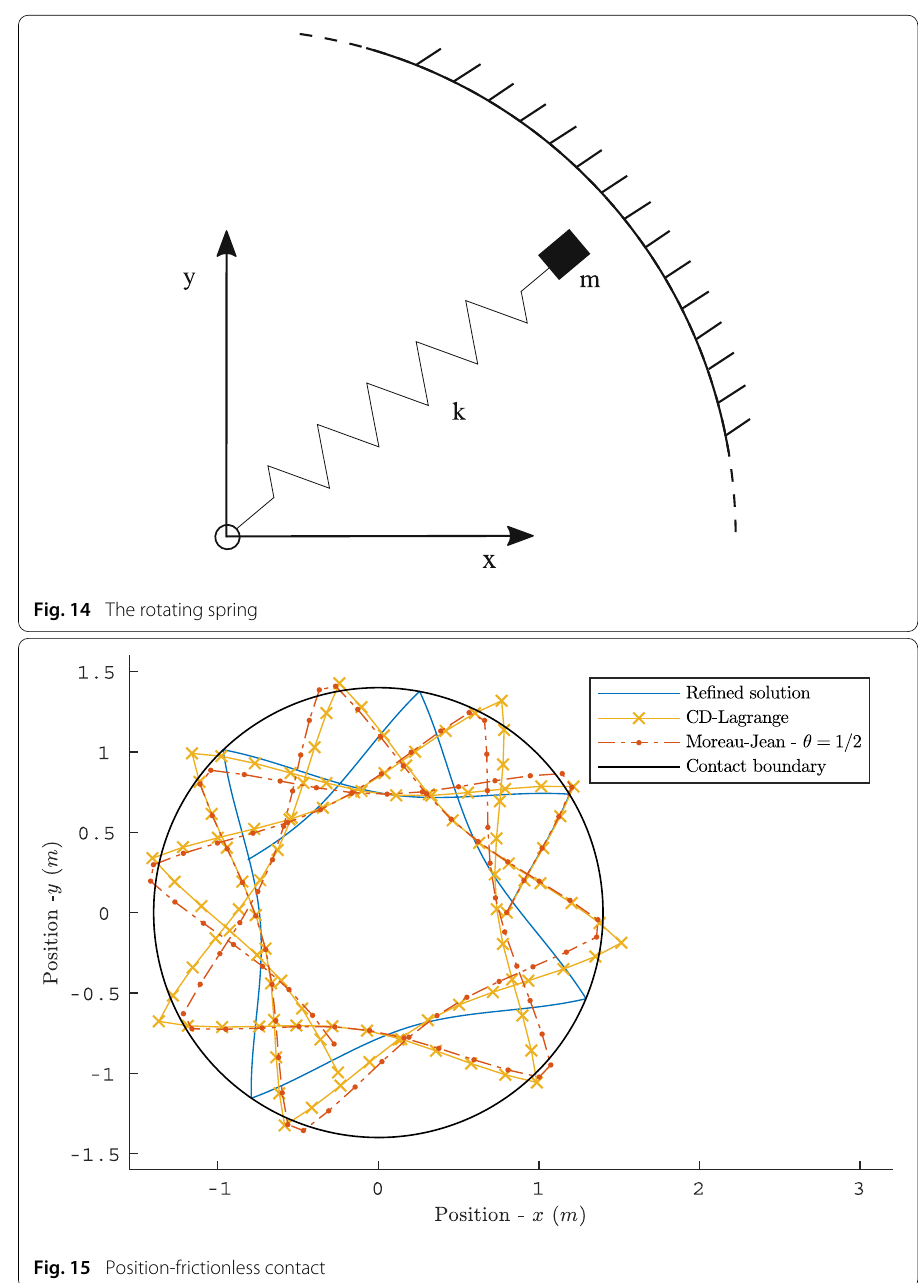
Fig. 15 Position-frictionless